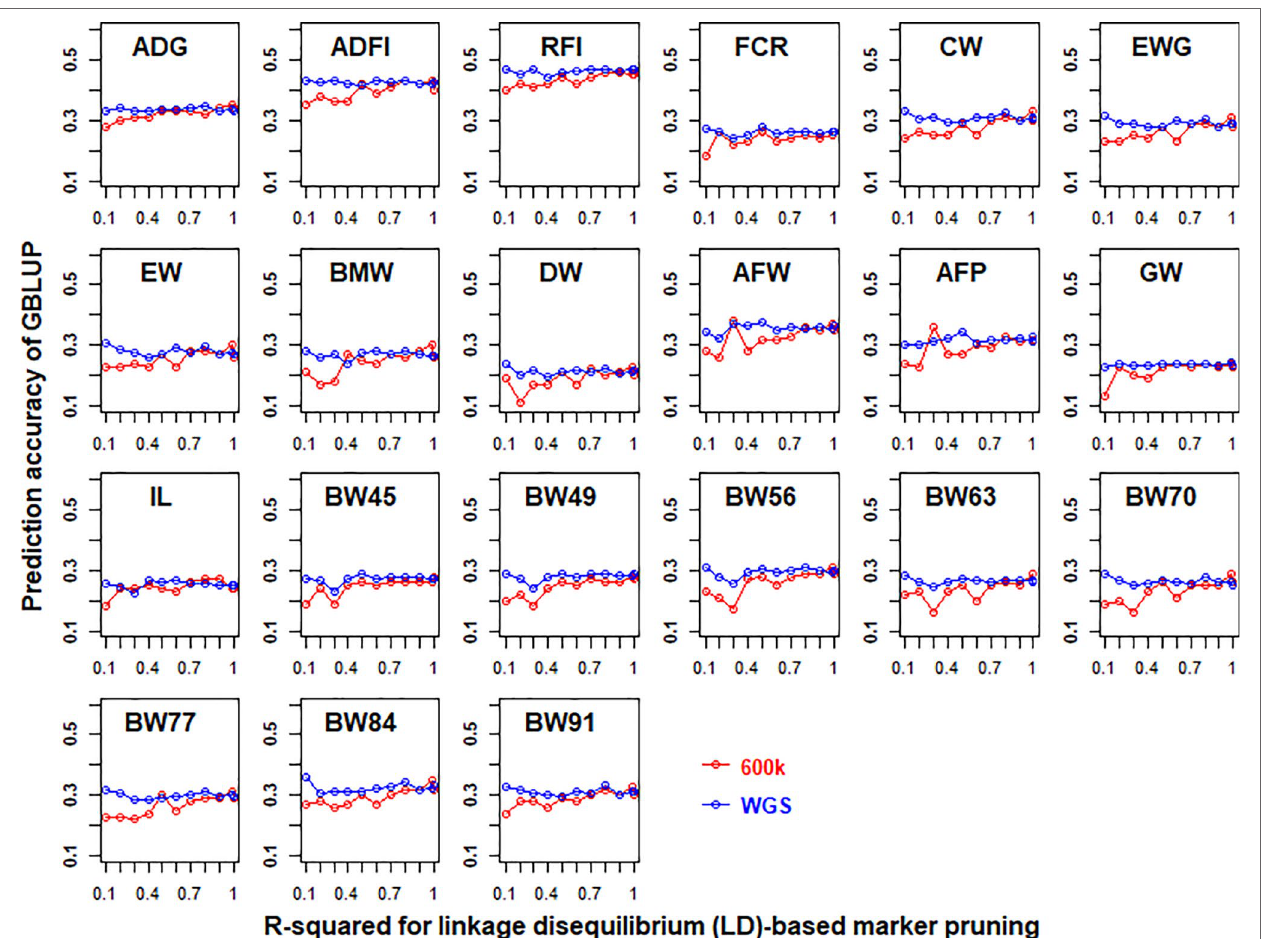
FIGURE 2 | Impact of linkage disequilibrium (LD)-based marker pruning on the predictive ability of imputed whole-genome sequencing (WGS) and chip data. Different R-squared cutoffs of LD (0.99, 0.9, 0.8, 0.7, 0.6, 0.5, 0.4, 0.3, 0.2, and 0.1) were used to prune markers of imputed WGS and chip data. The predictive ability was assessed by the Pearson correlation between the predicted genetic values and the observed phenotypes corrected for fixed effect per trait. These traits were average daily gain (ADG), average daily feed intake (ADFI), residual feed intake (RFI), feed conversion ratio (FCR), carcass weight (CW), breast muscle weight (BMW), eviscerated weight with giblets (EWG), eviscerated weight (EW), drumstick weight (DW), abdominal fat weight (AFW), abdominal fat percentage (AFP), gizzard weight (GW), intestine length (IL), body weight in 45 days (BW45), body weight in 49 days (BW49), body weight in 56 days (BW56), body weight in 63 days (BW63), body weight in 70 days (BW70), body weight in 77 days (BW77), body weight in 84 days (BW84), and body weight in 91 days